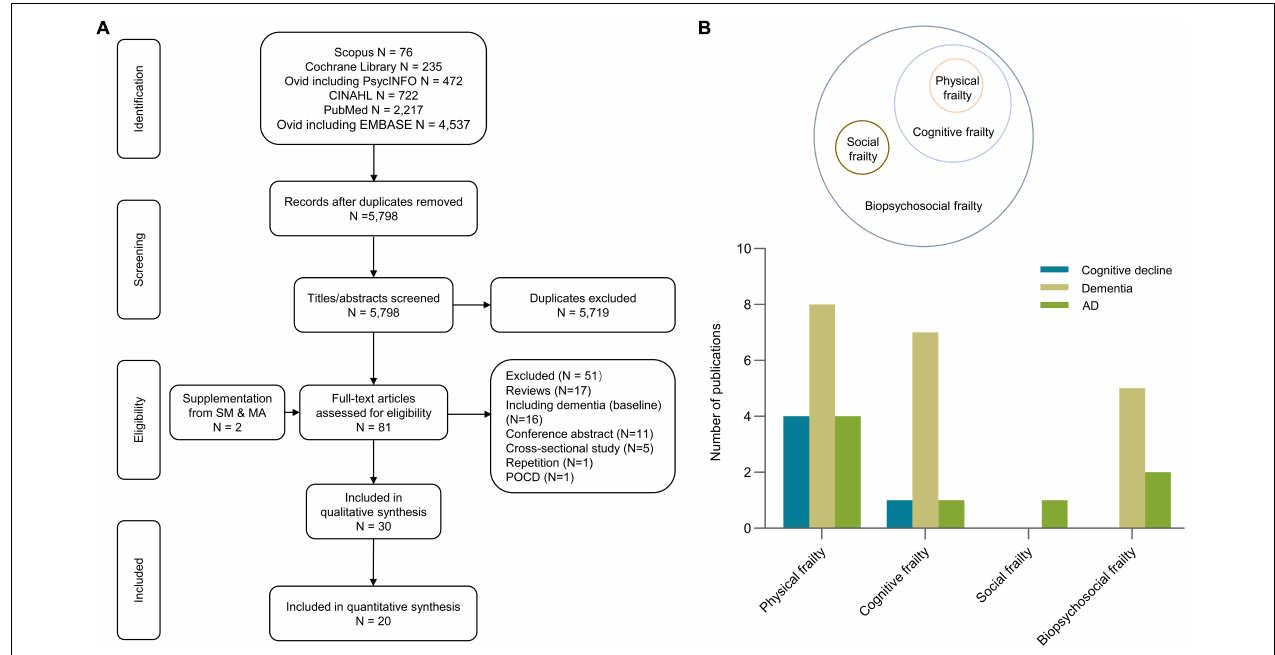
FIGURE 1 | Search flowchart (A) and summary characteristics of included studies (B) . The search yielded 5,798 literatures after deduplication. After scanning the titles and abstracts, 79 articles were considered as potentially eligible. After reviewing the bibliography and full-texts, 30 studies met the eligibility criteria, and 20 studies reporting risk estimates were included in the meta-analyze. AD, Alzheimer’s disease; POCD, postoperative cognitive dysfunctive; SM and MA, systematic review and